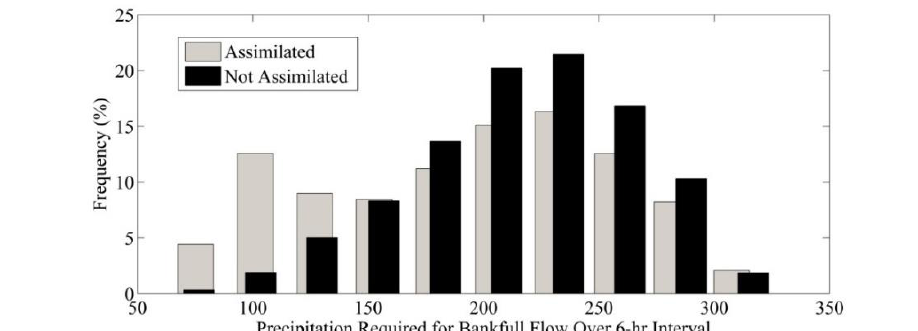
Figure 17. Frequency of 6-hr FFG values for ~350 basins where the inundation fraction exceeds